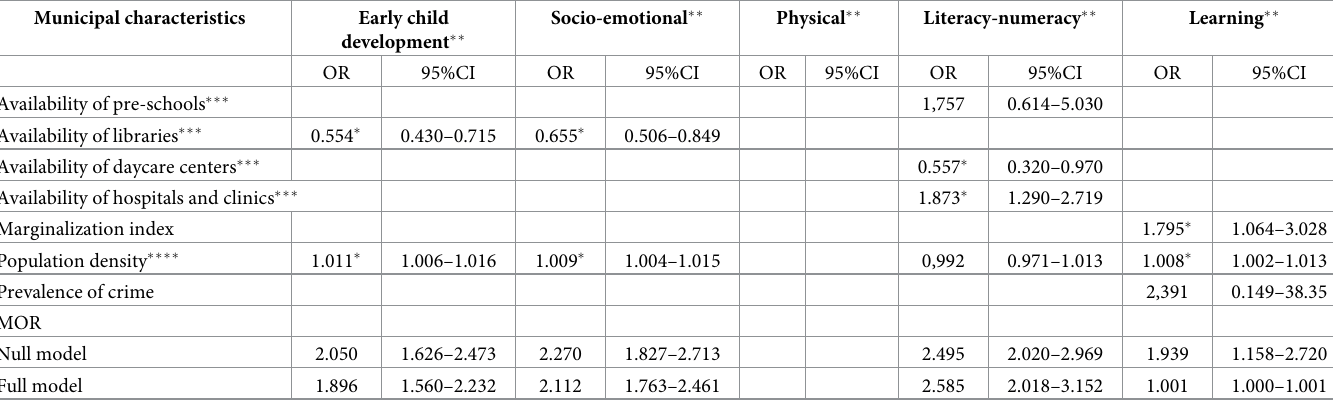
Table 4. Adjusted associations between overall inadequate early childhood development, domains, and urban